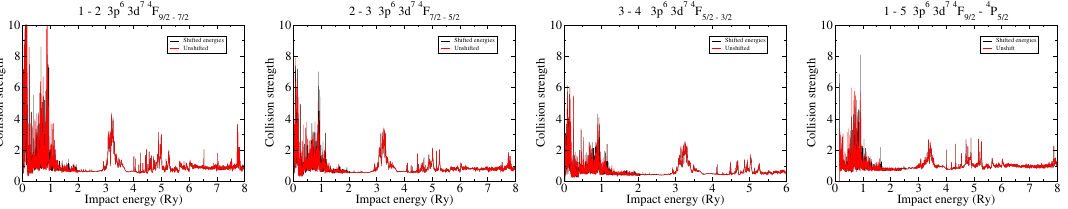
Figure 3. Electron-impact excitation collision strengths Ω of Ni 3 + .